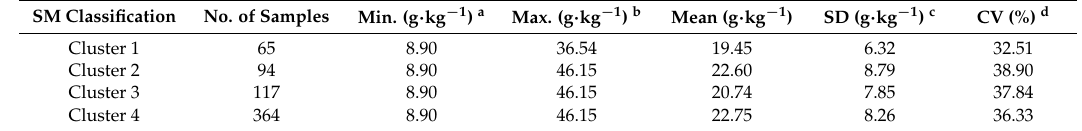
Table 1. Statistical characteristics of SOM using SM–based cluster method in the calibration dataset. SM Classification No. of Samples